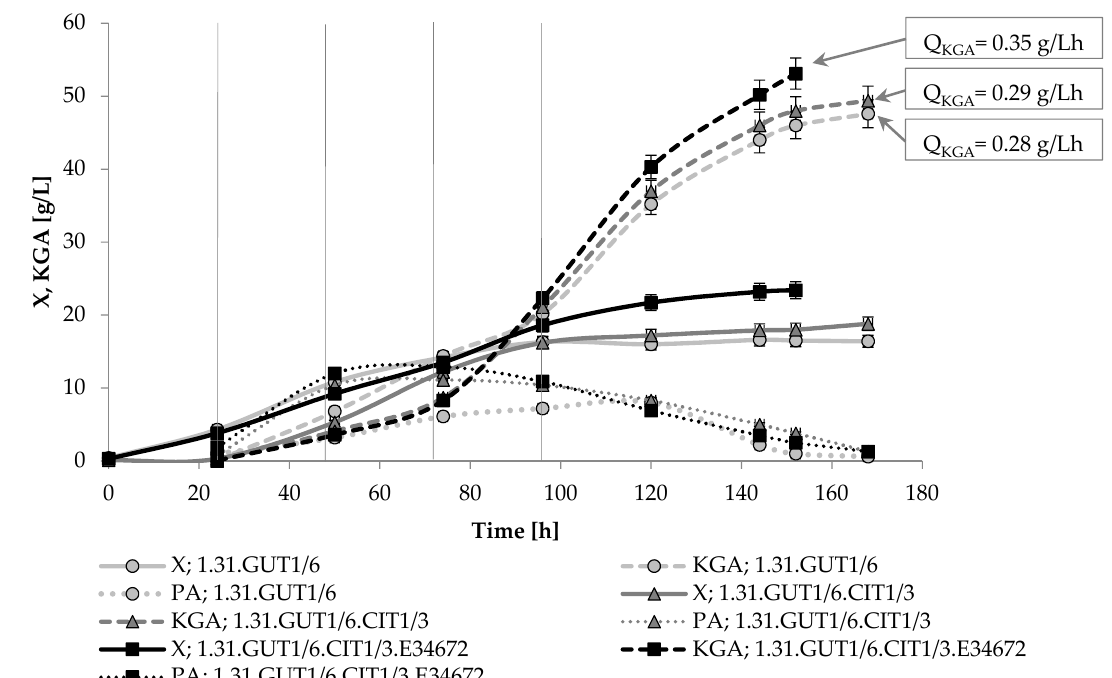
Figure 2. Kinetics of yeast growth (X) and production of α -ketoglutaric (KGA) and pyruvic (PA) acids by recombinant strains of Y. lipolytica growing on mixed (glycerol–oil) medium. Vertical lines indicate the time of dosing a portion of the substrate to the culture. Error bars represent the standard deviations of duplicates.